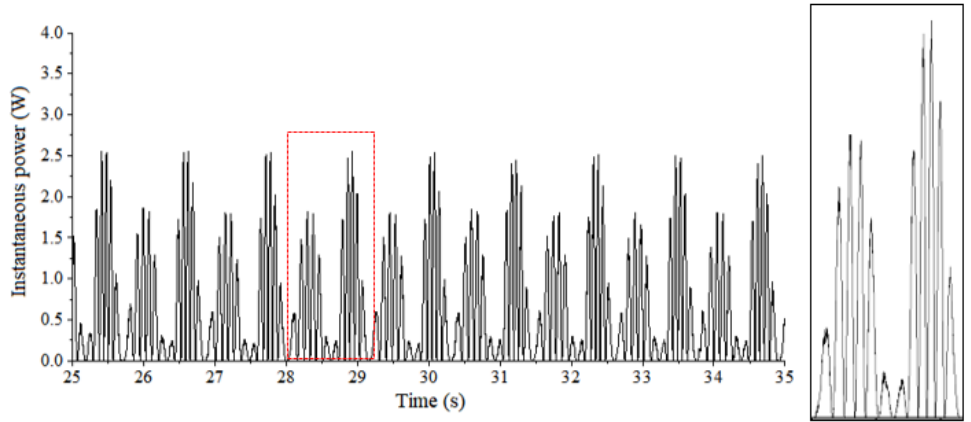
Figure 17. Instantaneous power diagram (including the zoom-up of the enclosed region between 28.0 s and 29.2 s) under traveling waves of T / T p = 1.0, h = 0.6 m.